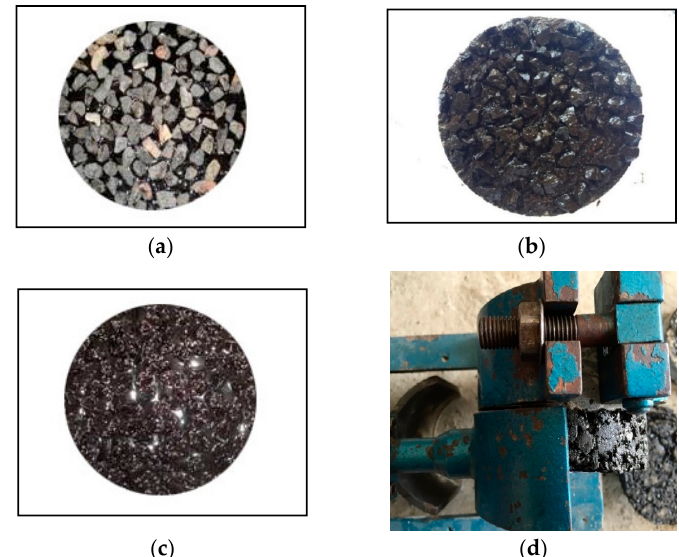
Figure 1. The forming and testing process of shear samples with different spreading schemes: ( a ) the sample forming process of Spreading scheme A; ( b ) the sample forming process of Spreading scheme B; ( c ) the sample forming process of Spreading scheme C; and ( d ) the Shear test process.